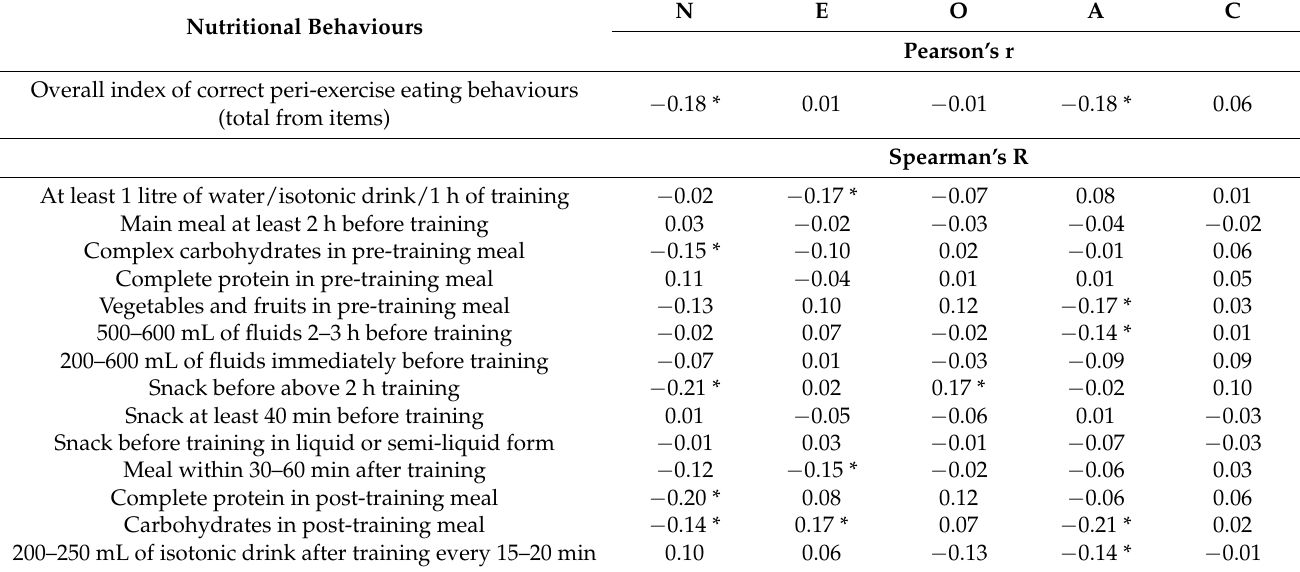
Table 3. Correlations between personality traits and implementing peri-exercise nutrition recommen- dations among athletes training team sports (Pearson’s r and Spearman’s R correlation coefficients). N Nutritional Behaviours